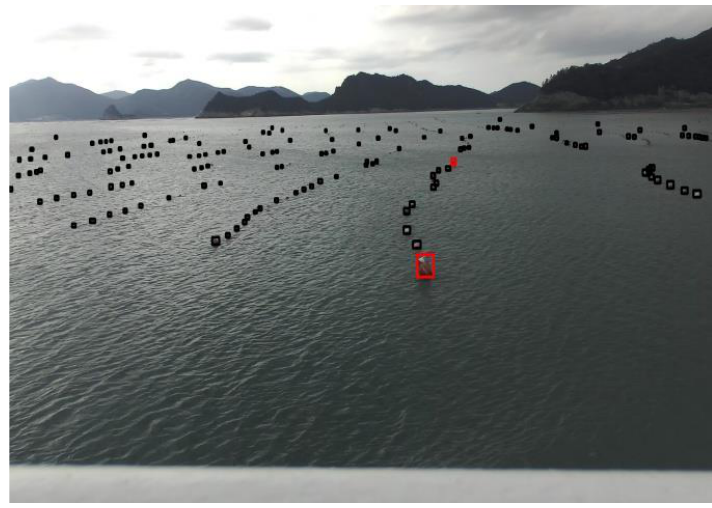
Figure 21. Feature-based stereo matching results (Experiment B).